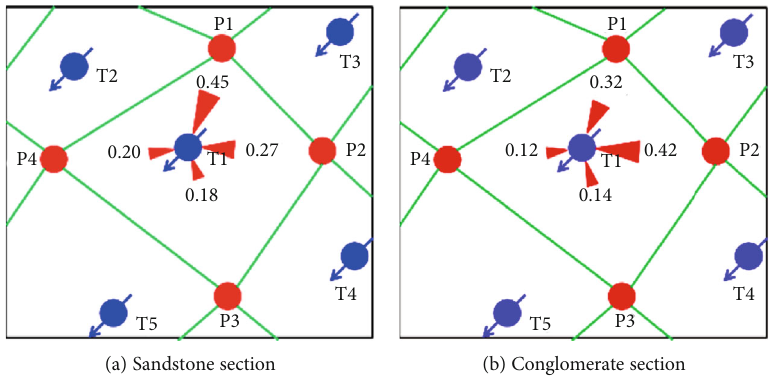
Figure 16: Water injection e ffi ciency of injectors.